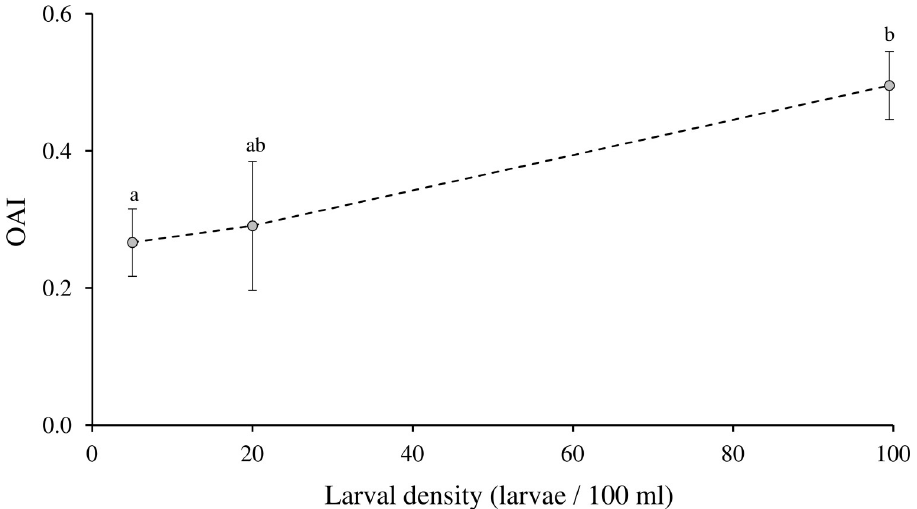
Fig 1. Oviposition activity index (OAI) of Ae . aegypti gravid females towards larval holding water (LHW) at three different densities: 5, 20 and 100 larvae / mL (mean ± S.E.M., n = 5 replicates per density). OAI value of 0 indicates no difference in oviposition between LWH and UPW bowls. Different letters indicate significant differences between densities (Tukey’s post-hoc test: P < 0.05).